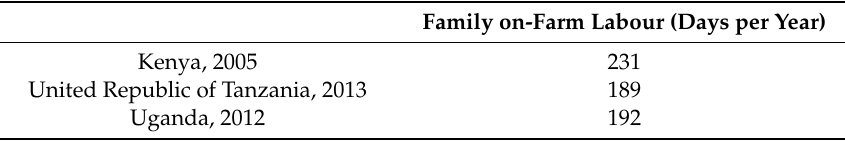
Table 4. Mean national summaries of on-farm labour (days per